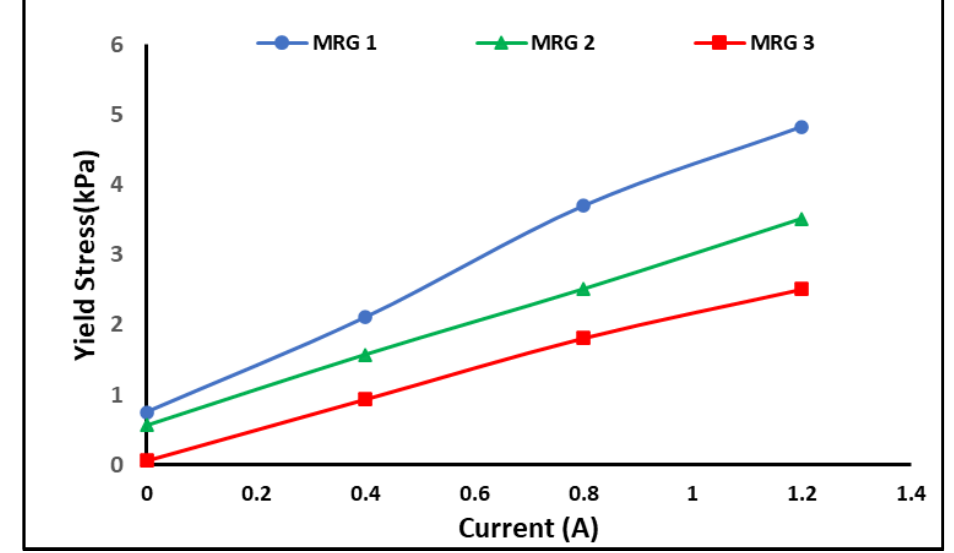
Figure 8. The yield stress of the MRG with different types of dilution oil under various applied